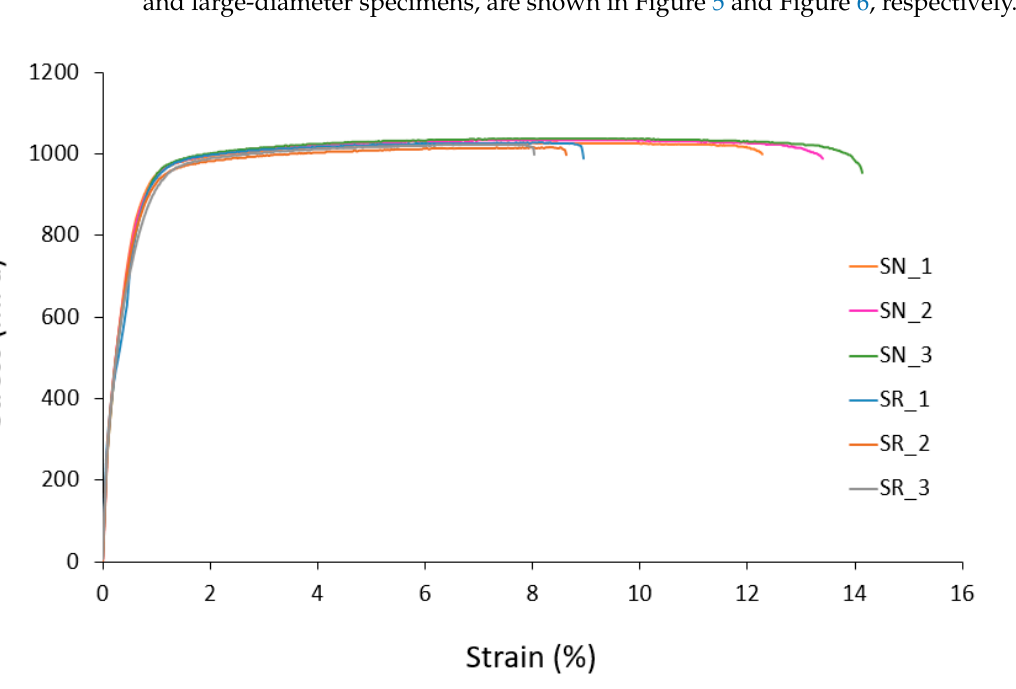
Table 1. Mechanical properties of the LPBF Ti-6Al-4V specimens, given as the mean ± standard deviation.